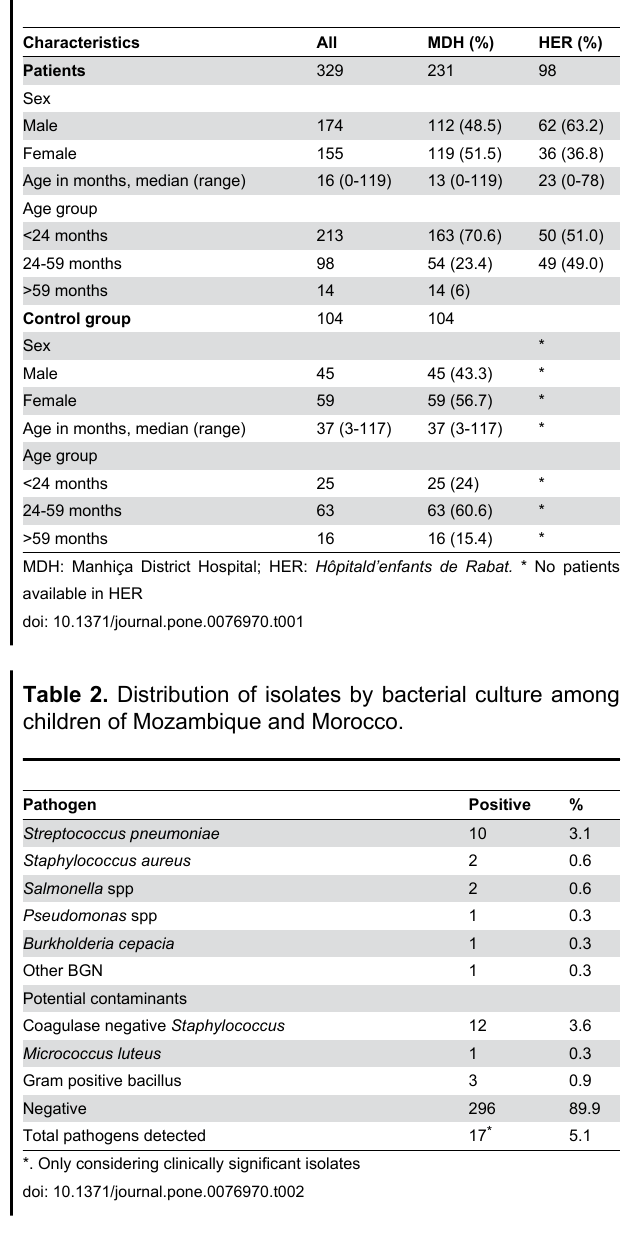
Table 1. Patients and control group characteristics.